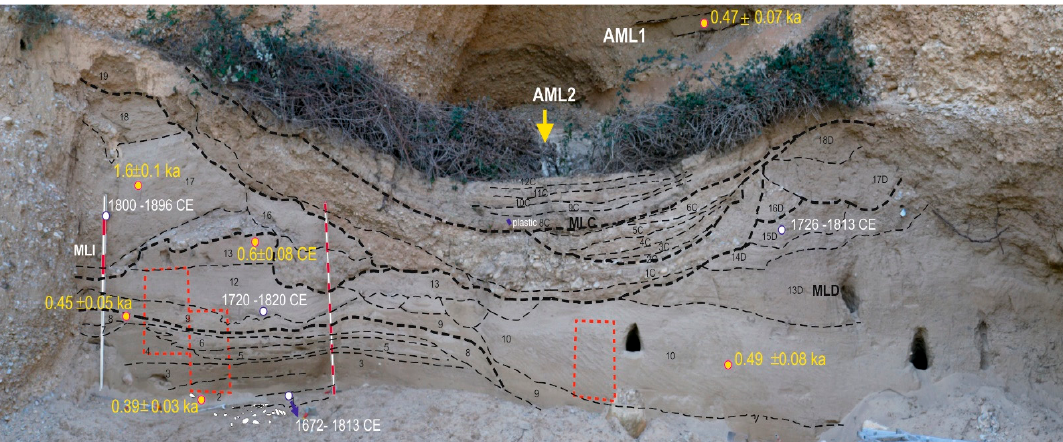
Figure 5. General view of the main alcove with indication of the stratigraphic units (fine dashed lines). Coarse dashed lines are contacts between the main stratigraphic packages. Most likely age range of calibrated Radiocarbon dating (white numbers) and luminescence dates results (yellow numbers) are indicated. AML1 and AM2 are inside the cave.